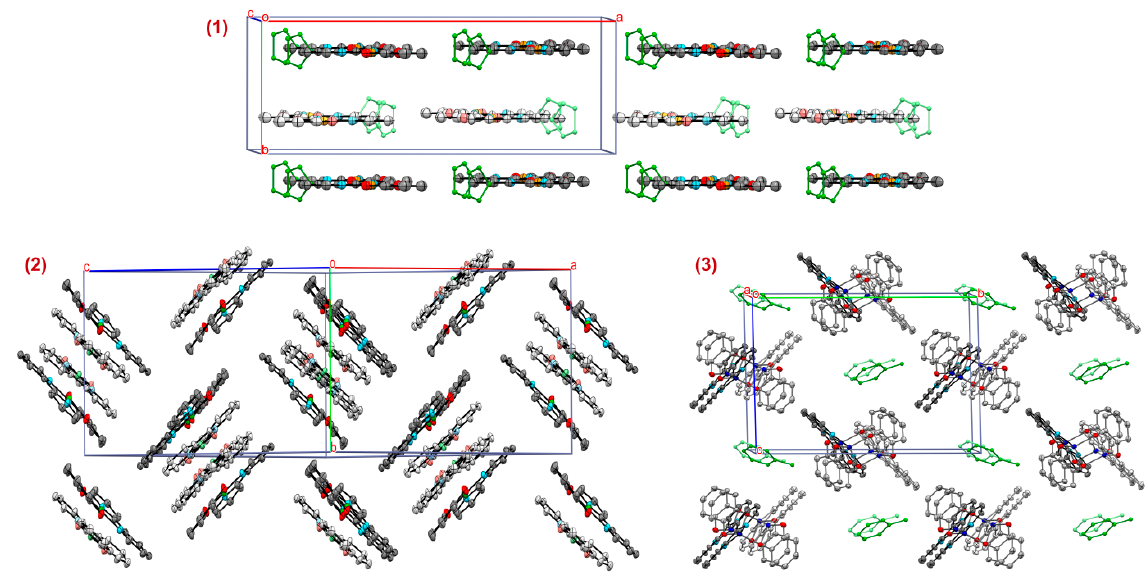
Figure 3. The fragments of crystal packings for complexes 1 – 3 . Faded views are given for: the molecules from even layer (in the case of compound 1 ); the molecules B (in the case of complex 2 ); one monomeric D-M II -A part (in the case of complex 3 ). Structures are given with 30% thermal probability ellipsoids. Hydrogen atoms and tert -butyl groups are omitted for clarity.